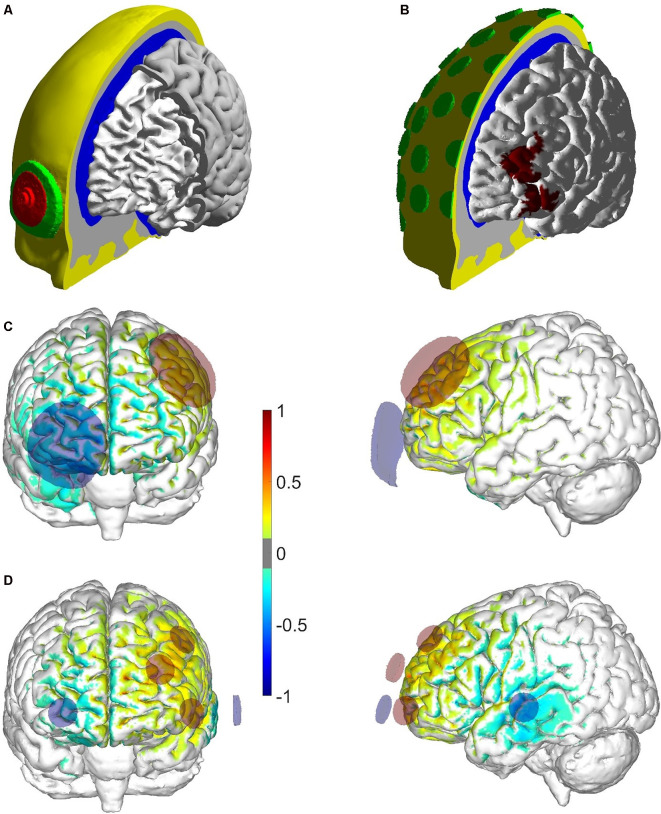
Geometry of the head model used in the optimization and E-field (En) modeling pipeline. (A) Global view of the different tissues in the head model, as well as the SpongeStim electrode model (saline-soaked sponge in green and rubber connector in red). The thickness and radius of the different components of the electrode were based on measurements of the actual electrode. (B) Global view of the head model used in the optimization pipeline, including representations of the conductive gel underneath the PiStim electrodes. The mask of the left dorsolateral prefrontal cortex (lDLPFC) used in the optimization (BA 46) is also shown in the cortical surface of the head model. (C,D) Distribution of the normal component of the E-field in the bipolar/multichannel montage (positive/negative values indicate that the En field is directed into/out of the cortical surface). The field was divided by its maximum value in each montage (0.52 V/m in the bipolar montage and 0.70 V/m in the multichannel).